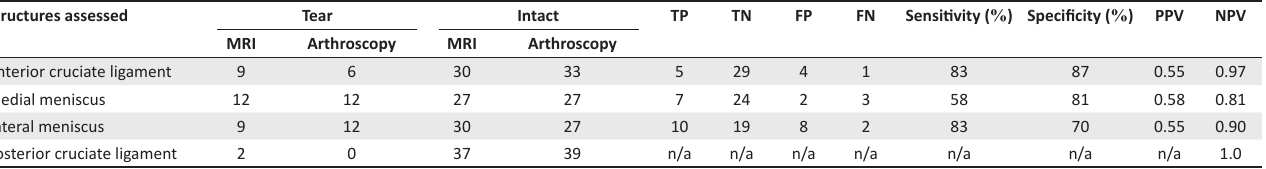
TABLE 1: Results of each structure evaluated. Structures